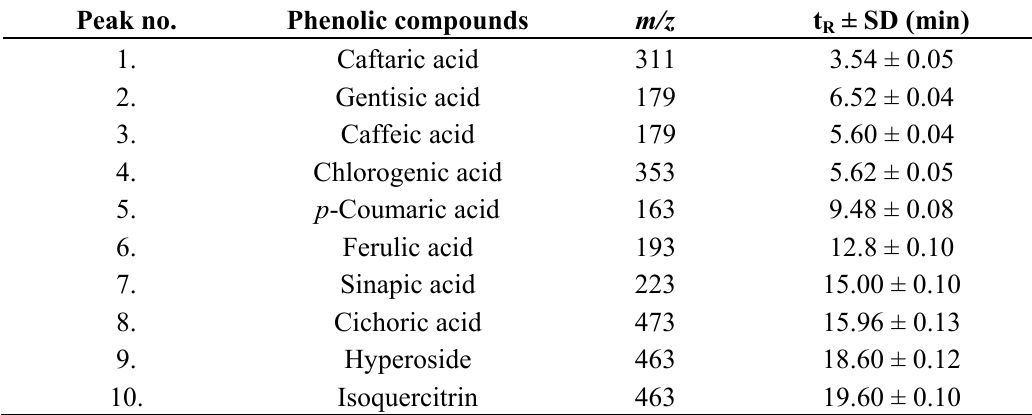
Table 2. Retention times (RT) of polyphenolic compounds (min). Peak